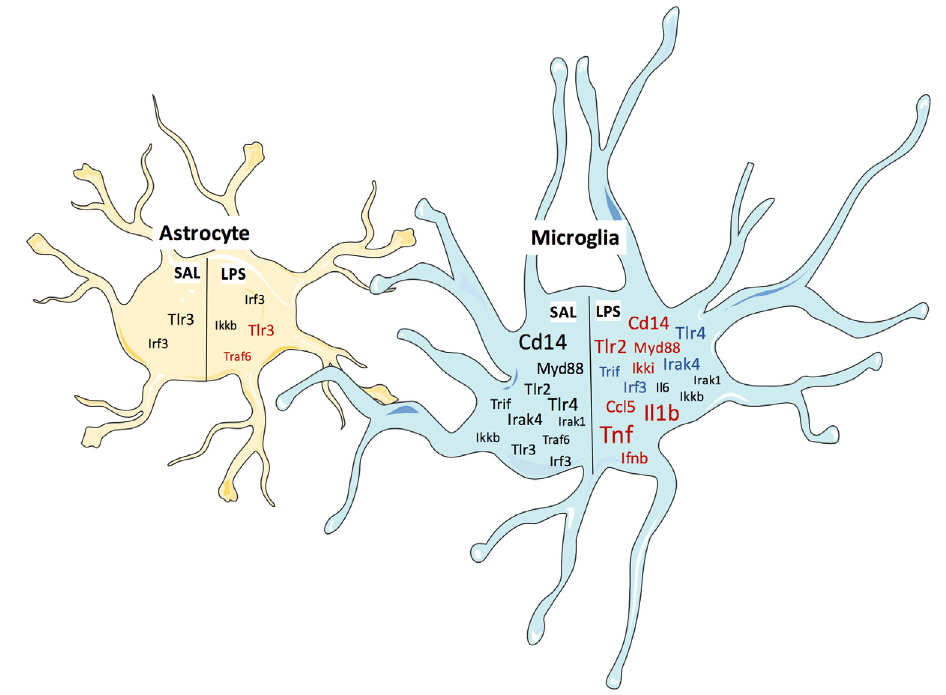
Figure 8. Summary of mRNA enrichment and LPS response. Microglial and astrocyte cell-type enrichment (compared to TH) is shown for TLR pathway genes in saline and LPS treated mice. The font size of each gene indicates fold-enrichment, with larger sizes meaning larger fold-enrichment. Colors on the LPS side denote whether that gene changed in that cell type with LPS treatment. Red indicates increased gene expression while blue denotes decreased gene expression. Figure created using